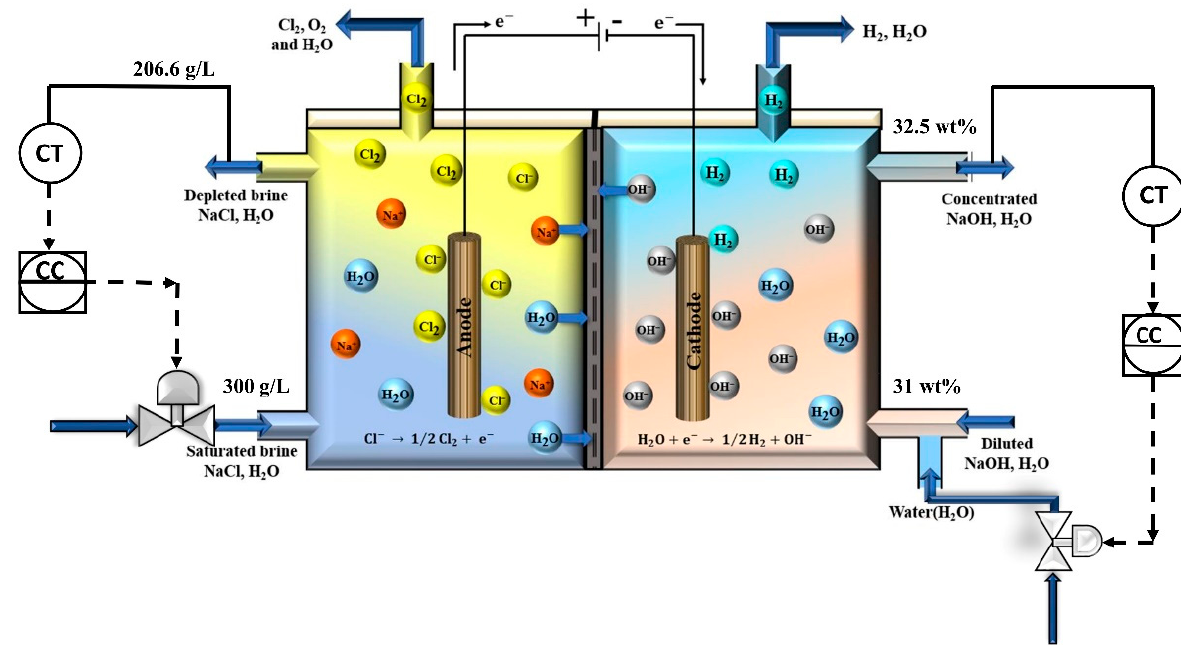
Figure 1. The cell consists of anode and cathode compartments, which are separated by the CEM. An ultrapure saturated brine with a concentration of 300 gL − 1 NaCl enters the anode compartment where the chloride ions are oxidized to produce Cl 2 (Equation (1)) and sodium ions migrate through the membrane to the cathode compartment [33,34].